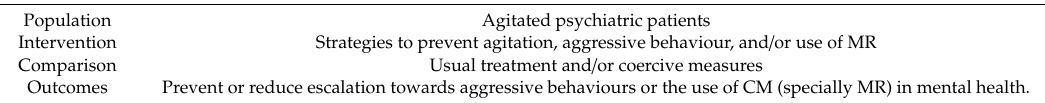
Table 1. Structure of the research question through the population, intervention, comparison, and outcomes (PICO) format.